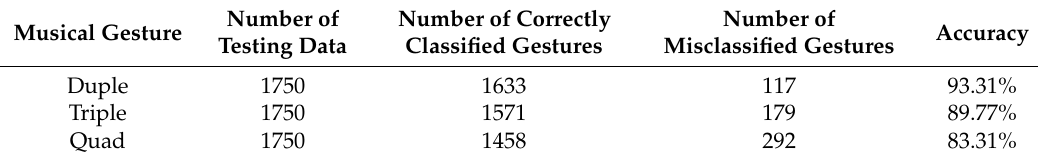
Table 3. Accuracy of musical conducting gesture recognition classified by